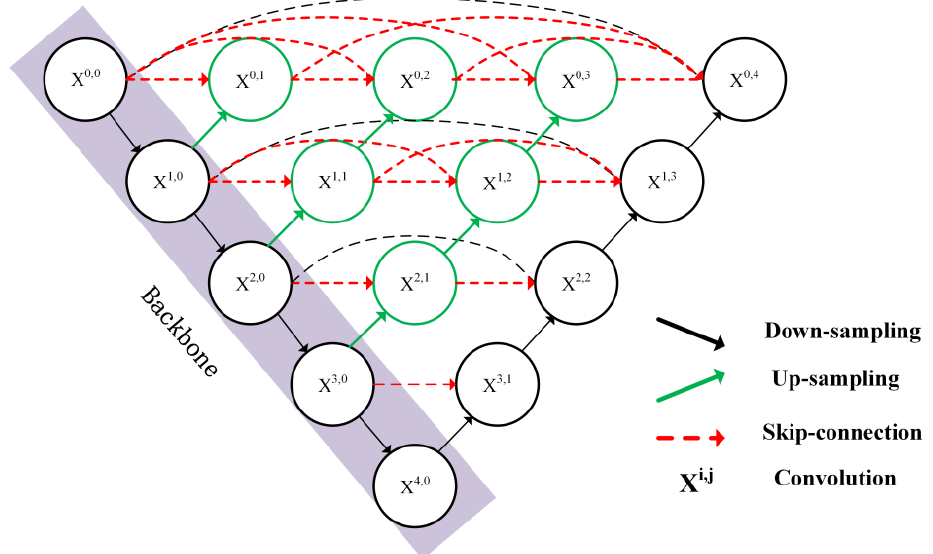
Figure 5. The architecture of U − Net++. [54] The purple part represents the feature extraction layers, which are replaced with ResNet50. X 0,0 is the input data, and X 0,4 is the final binary result. The Skip connection fuses the feature maps generated from the up and current layers.